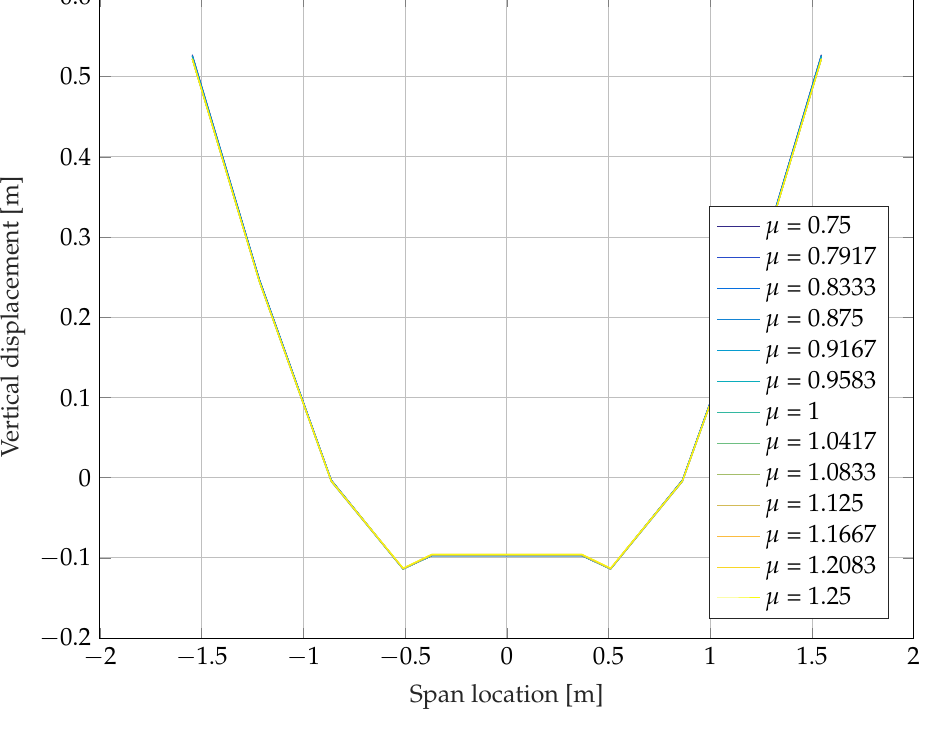
Figure 11. 1st symmetric bending